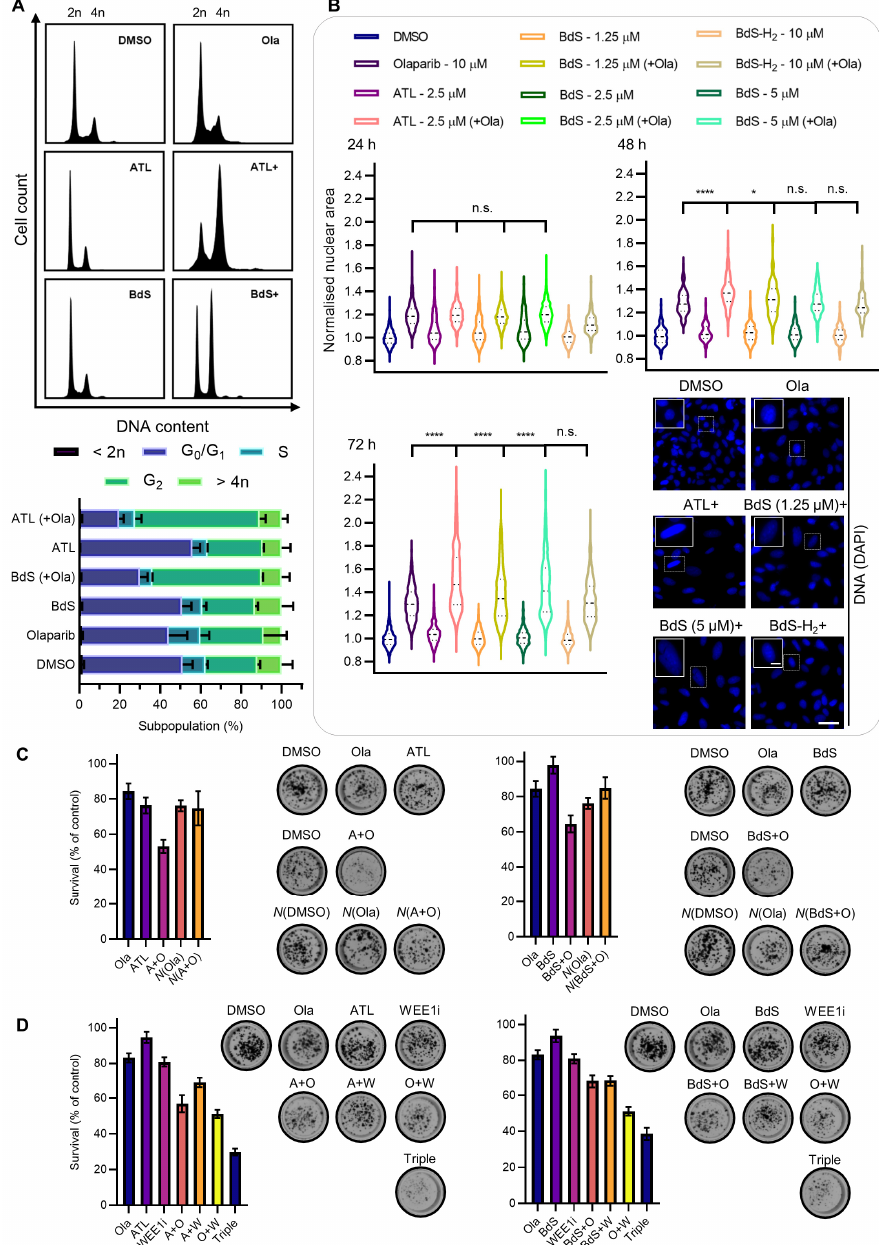
Figure 6. BdS and alantolactone (ATL) synergistically potentiate olaparib ‐ induced cell growth in ‐ hibition in p53 wildtype cancer cells. ( A ) Propidium iodide (PI) ‐ treated U2OS cell ‐ cycle analysis after 48 h of drug treatment. Representative cell ‐ cycle distributions depicting DNA content (top) and histograms (bottom) are shown for two independent experiments ( n = 2; mean ± SEM). ( B ) Normalised nuclear area quantifications and representative images of the DAPI ‐ stained U2OS nu ‐ clei (bottom right; 72 h time point) after treatment with olaparib (10 μ M), ATL (2.5 μ M), BdS (1.25, 2.5, 5 μ M) and/or BdS ‐ H 2 (10 μ M) at the indicated time points (dotted lines show median and quartiles). For the 24 h time point, each dataset represents a minimum of 25,000 cells (4 independ ‐ ent experiments; n = 672, except for BdS ‐ H 2 and its combination treatment which represent a min ‐ imum of 6250 cells—1 independent experiment; n = 168). For the 48 h time point, each dataset rep ‐